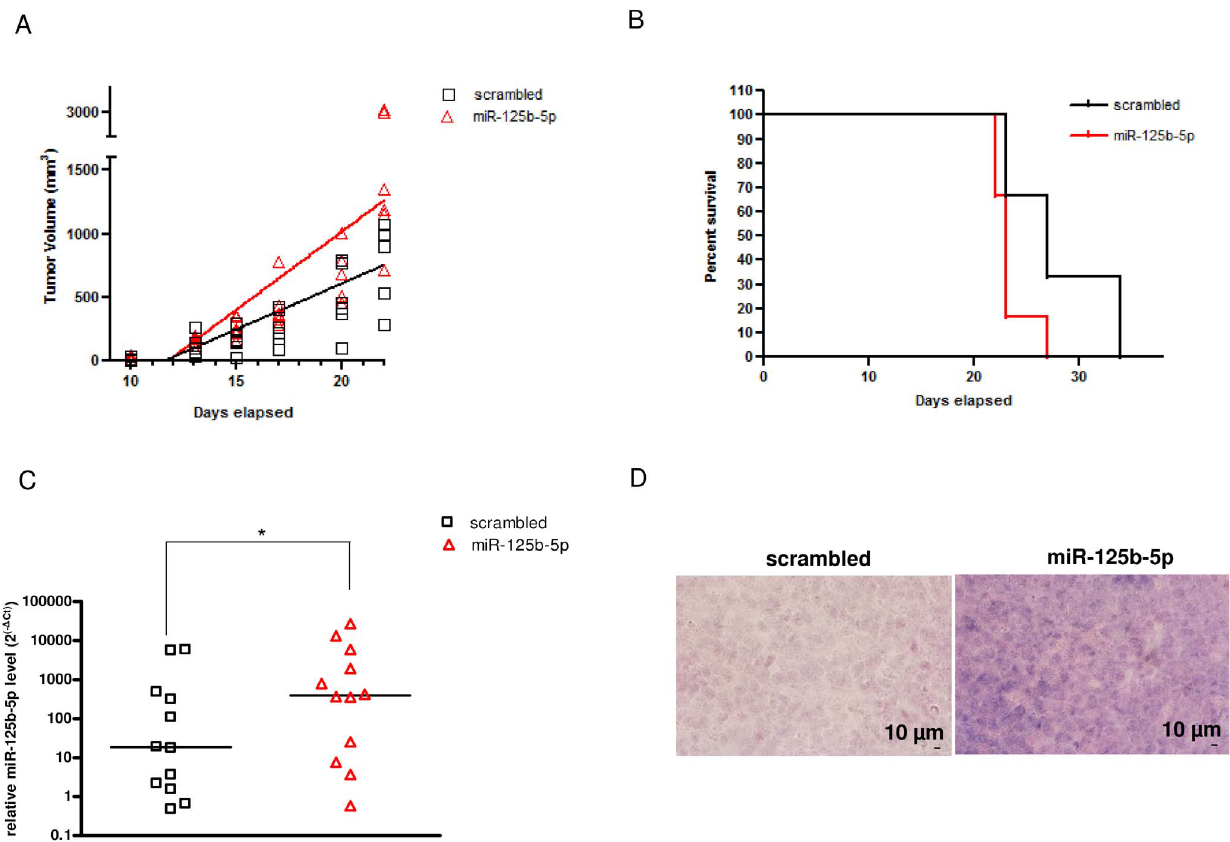
Figure 6. miR-125b-5p facilitates tumorigenesis invivo . (A) Linear regression analysis of the in vivo tumor volume in 12 NSG mice (n=6/group) after xenotransplantation of MyLa cells transfected with miR-125b-5p or scrambled oligonucleutide. The tumor growth rate represented by the slope of the linear regression was statistically different in the miR-125b-5p group compared to the scrambled one ( P =0.03). Each point represents a single measurement. (B) Kaplan-Meier survival curve showing a significant (Log-Rank Mantel Cox test P =0.04) shorter median survival in the miR-125b-5p group compared to the scrambled one. (C) miR-125b-5p expression in miR-125b-5p and scrambled tumors was quantified by qRT-PCR (* P , 0.05). Each point represents the miR-125b-5p level in one tumor tissue and the line corresponds to the median value of miR-125b-5p in the miR-125b-5p and scrambled tumors. (D) A representative ISH from 6 cases of paraffin sections of miR-125b-5p or scrambled tumors using miR-125b-5p-specific LNA probe. miR-125b-5p expression was high in all tumors within the miR-125b-5p group, while it was almost undetectable in the tumors within the control group. Images were acquired using a Nikon D60 digital single-lens reflex (D-SLR) camera. Original magnification x20 for both panels. Scale bar, 10 m